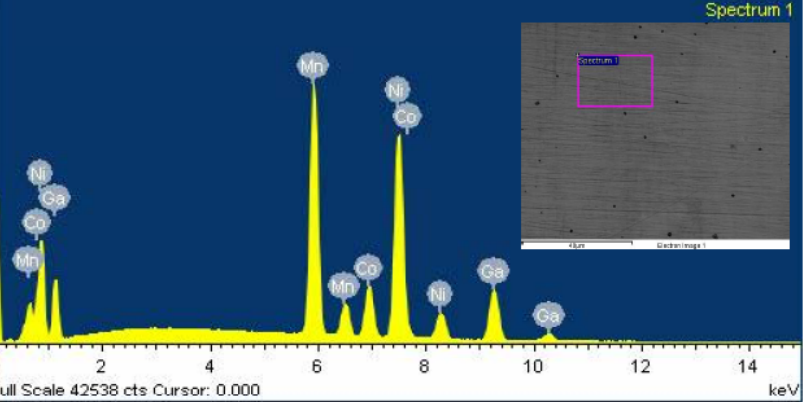
Figure 5. EDX spectrum of Ni microscopic image. The little rectangle marks the position at which the EDX